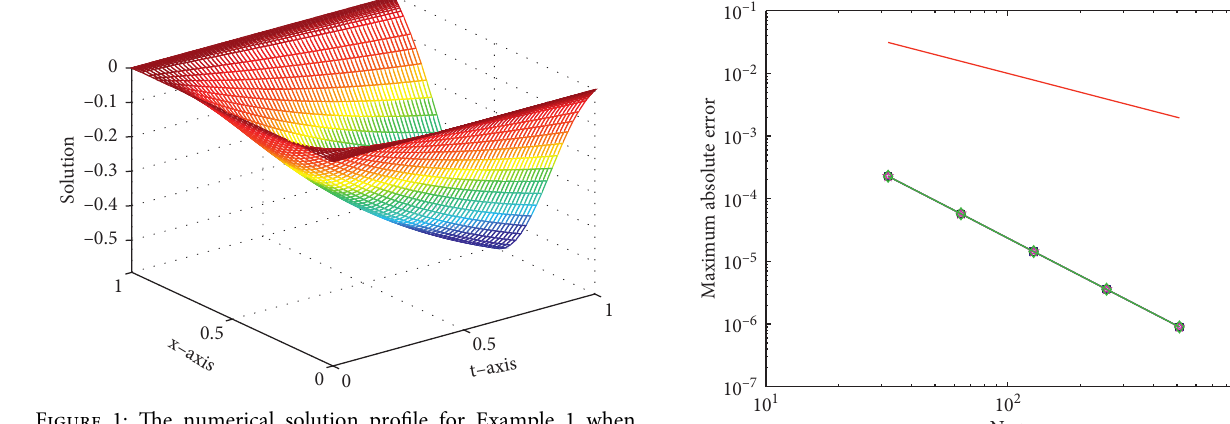
Figure 1: The numerical solution profile for Example 1 when N � 64 , M � 64 , ε � 10 − 2 , and μ � 10 − 10 .